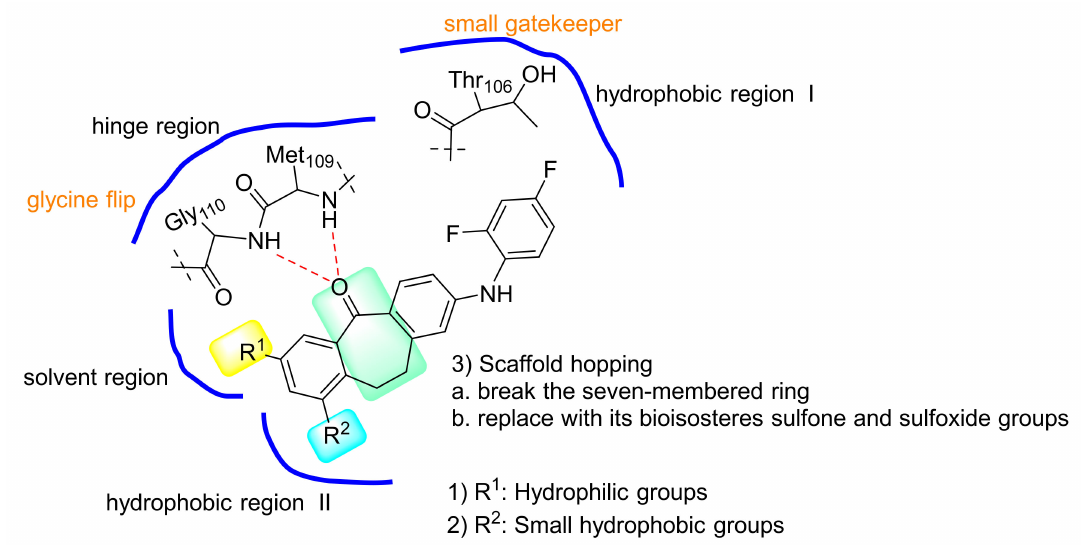
Figure 3. Design and optimization strategies of novel MAPK11